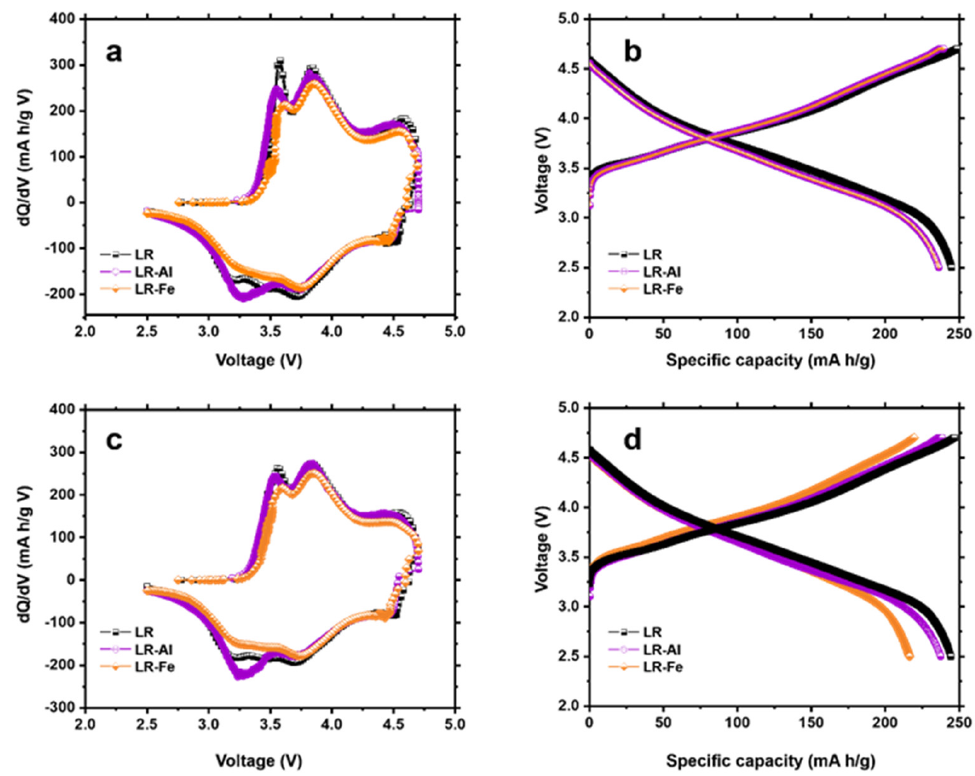
Figure 7. ( a , c ) dQ/dV) plots and ( b , d ) corresponding charge–discharge curves for the 7, 8 cycles in the potential ranges of 2.5–4.7 V.